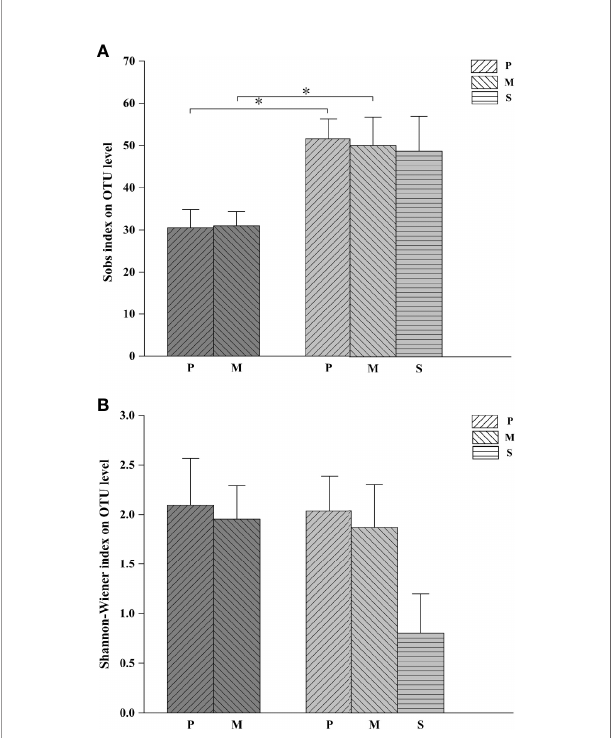
FIGURE 1 | Sobs (A) and Shannon-Wiener (B) indices of stomach contents of cultured organisms. Dark Gray represents the PM system and light gray represents the PMS system; P represents P. trituberculatus ; M represents M. japonicus ; S represents S. constricta ; * indicates signi fi cant difference among groups ( P <